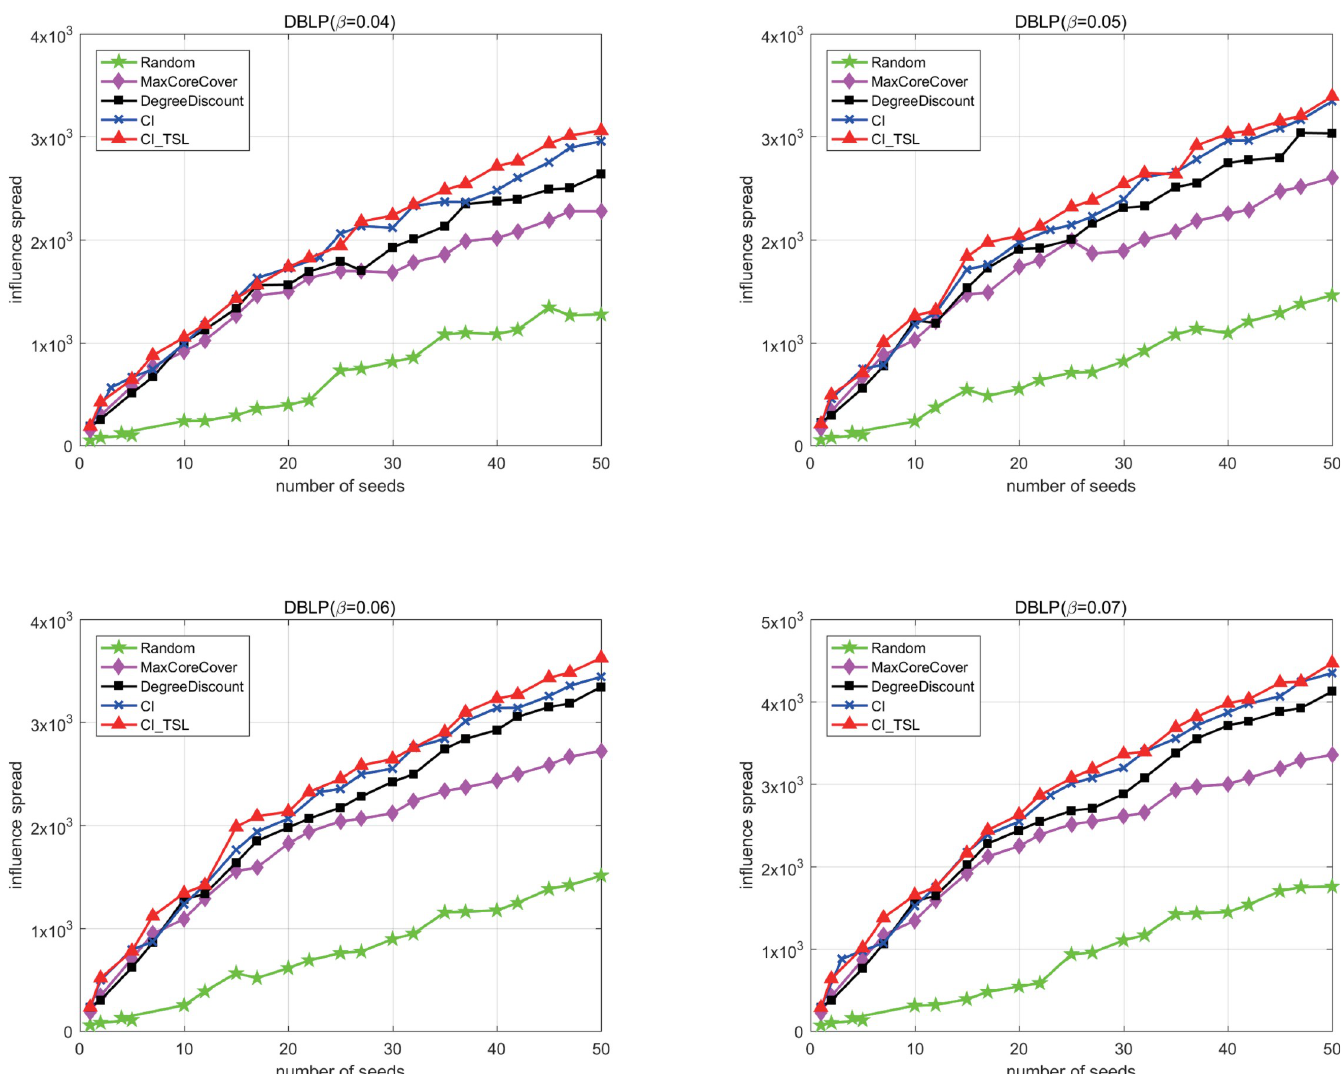
Fig 5. The spreading influence of different algorithms on the DBLP based on TSSCM with different β